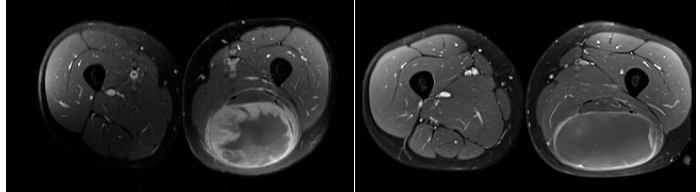
Figure 2. MRI images showing changes of the tumor and contrast uptake after treatment ( a ) prior to treatment, ( b ) prior to surgery.